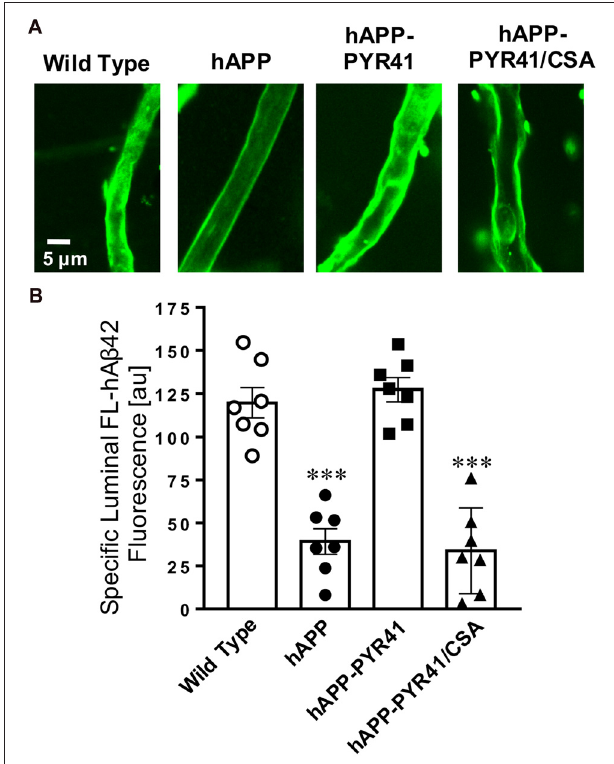
FIGURE 3 | PYR41 treatment restores P-gp-mediated hA β 42 transport in hAPP mice. (A) Representative confocal images of isolated brain capillaries from WT, hAPP, hAPP-PYR41 and hAPP-PYR41/CSA mice after a 1 h incubation with 5 µ M FL-hA β 42 . (B) Data from ImageJ analysis of confocal images in (A) show that luminal FL-hA β 42 levels were significantly reduced in brain capillaries from hAPP and hAPP-PYR41/CSA mice relative to brain capillaries from WT and hAPP-PYR41 mice. In contrast, luminal FL-hA β 42 fluorescence levels in brain capillaries from PYR41-treated hAPP mice are comparable to those in isolated brain capillaries from WT mice indicating that PYR41-treatment restored P-gp transport activity. Specific FL-hA β 42